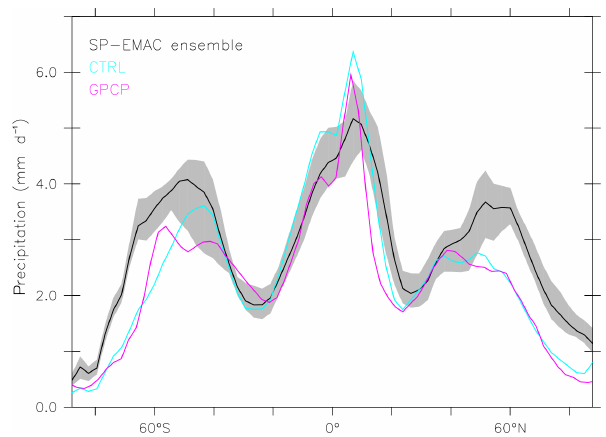
Figure 3. Zonal-averaged simulated precipitation compared to GPCP